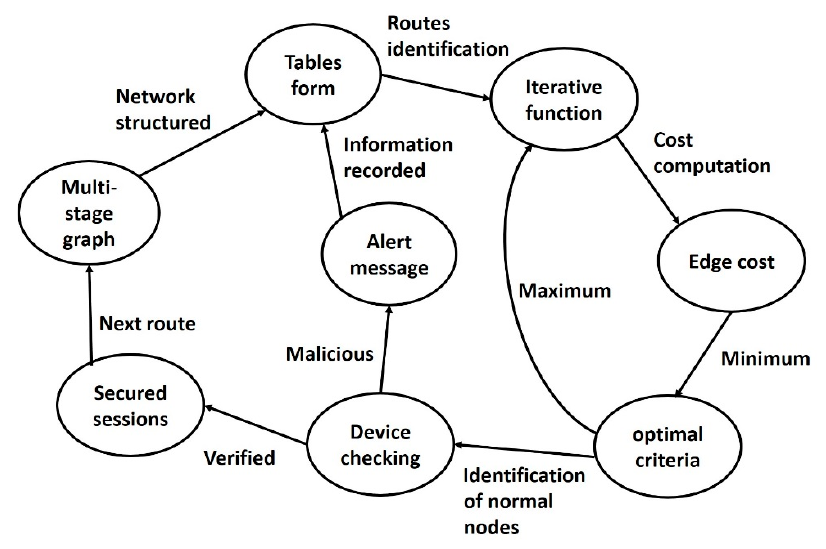
Figure 1. States of the SDS-GIoT model.